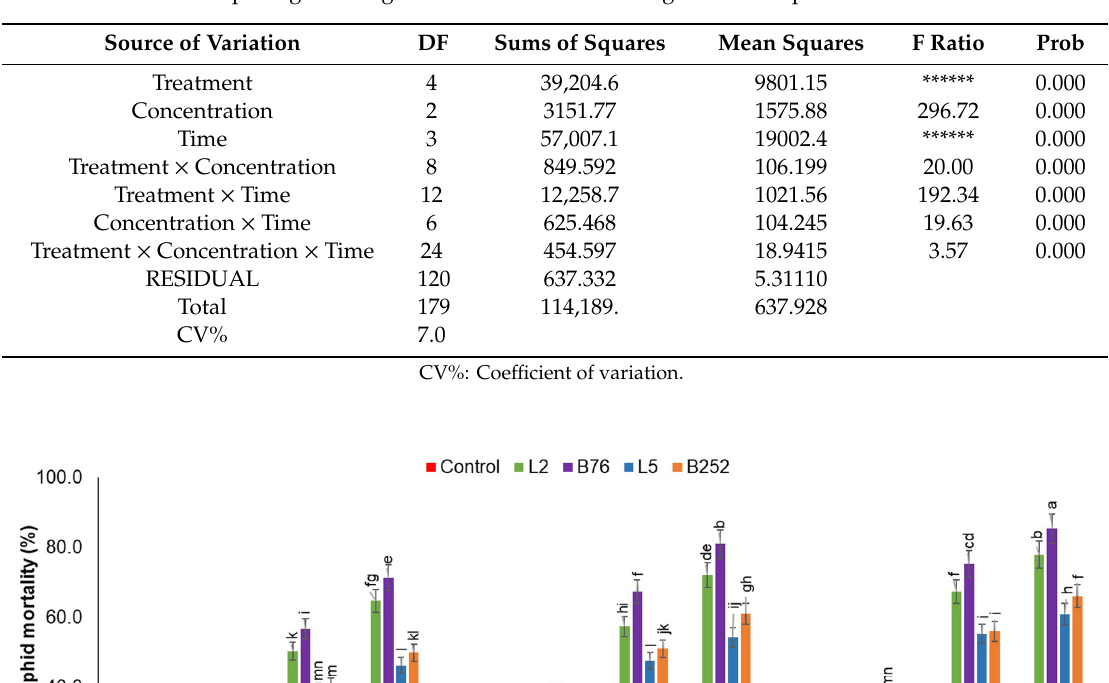
Table 1. Analysis of variance (ANOVA) for the mortality of M. japonica by three di ff erent concentrations from four entomopathogenic fungi strains at di ff erent times against bean aphids.